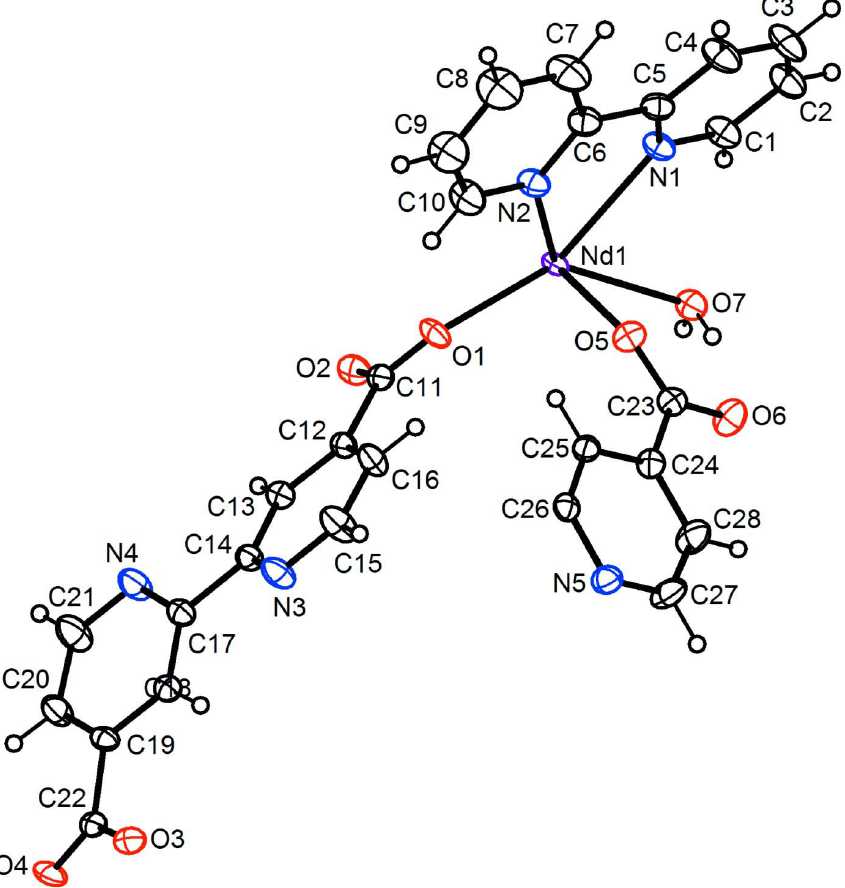
The atom numbering scheme of the title compound presented in the crystallographically asymmetric unit. The atomic displacement ellipsoids are drawn at the 50% probability